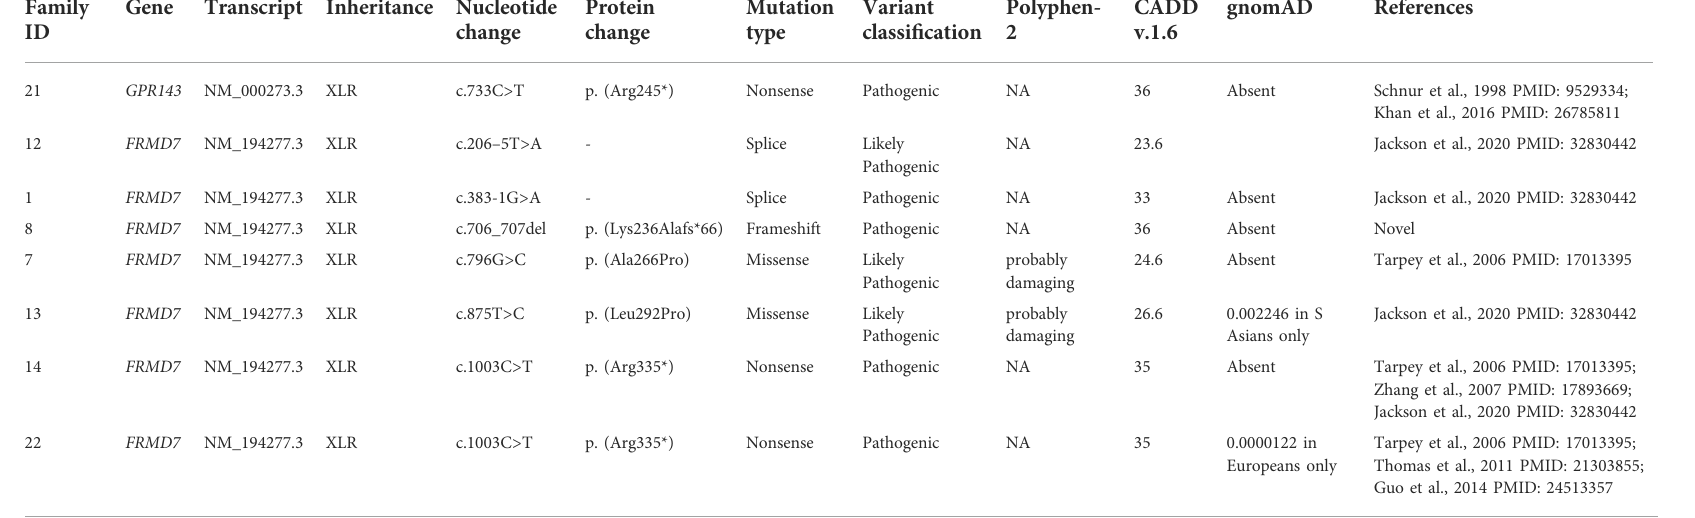
TABLE 2 List of variants in molecularly con fi rmed idiopathic infantile nystagmus